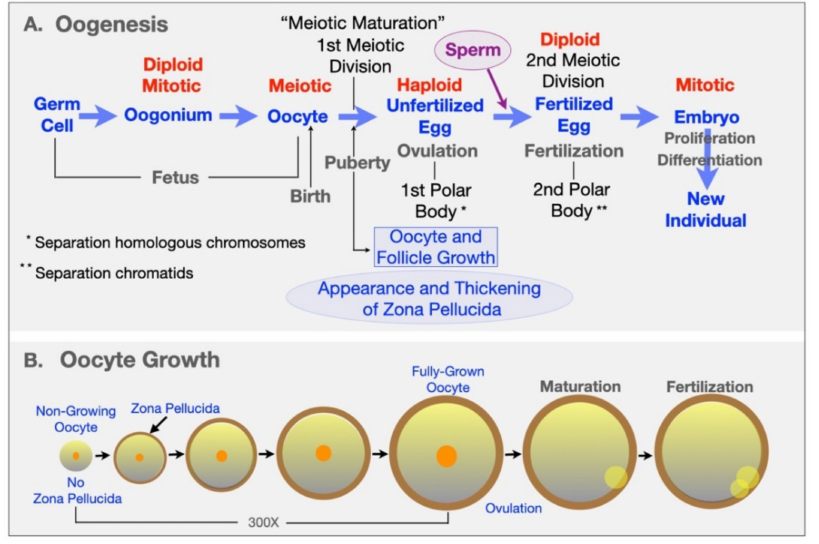
Figure 2. ( A ) Schematic representation of steps involved in the conversion of female germ cells in the mouse fetus to fertilized eggs in the adult mouse. In the fetus primordial germ cells convert to mitotic oogonia and then to meiotic oocytes with crossing over and recombination. Soon after birth, all oocytes are arrested in meiosis at diplotene (dictyate) of the first meiotic prophase. At puberty, during each reproductive cycle, some mouse oocytes grow ≈ 300-fold in volume over ≈ 2–3 weeks, their surrounding follicle cells proliferate and differentiate, and fully grown oocytes surrounded by cumulus cells are ovulated. At about the time of ovulation, oocytes undergo meiotic maturation with emission of a first polar body following separation of homologous chromosomes (1st meiotic division). In this manner fully grown oocytes become haploid unfertilized eggs. Upon fusion with a single sperm, fertilized eggs emit a second polar body following separation of chromatids (2nd meiotic division) but are restored to a diploid state by the haploid sperm genome. ( B ) Schematic representation of ZP production during oocyte growth in mice. Non-growing oocytes lack a ZP, but as soon as oocyte growth begins, they lay down a ZP that continues to thicken throughout the growth phase ( ≈ 2–3 weeks; ≈ 300-fold increase in oocyte volume) and results in a 6.2 ± 1.9 µ m thick ZP around fully-grown oocytes and ovulated eggs. The ZP remains around the early embryo until the expanded blastocyst stage when the embryo hatches from the ZP and implants in the